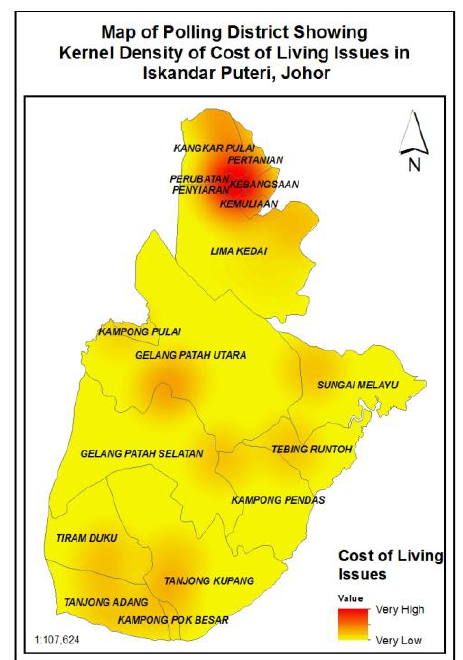
Figure 10. Result of the hot spot maps using KDA for cost of living issues